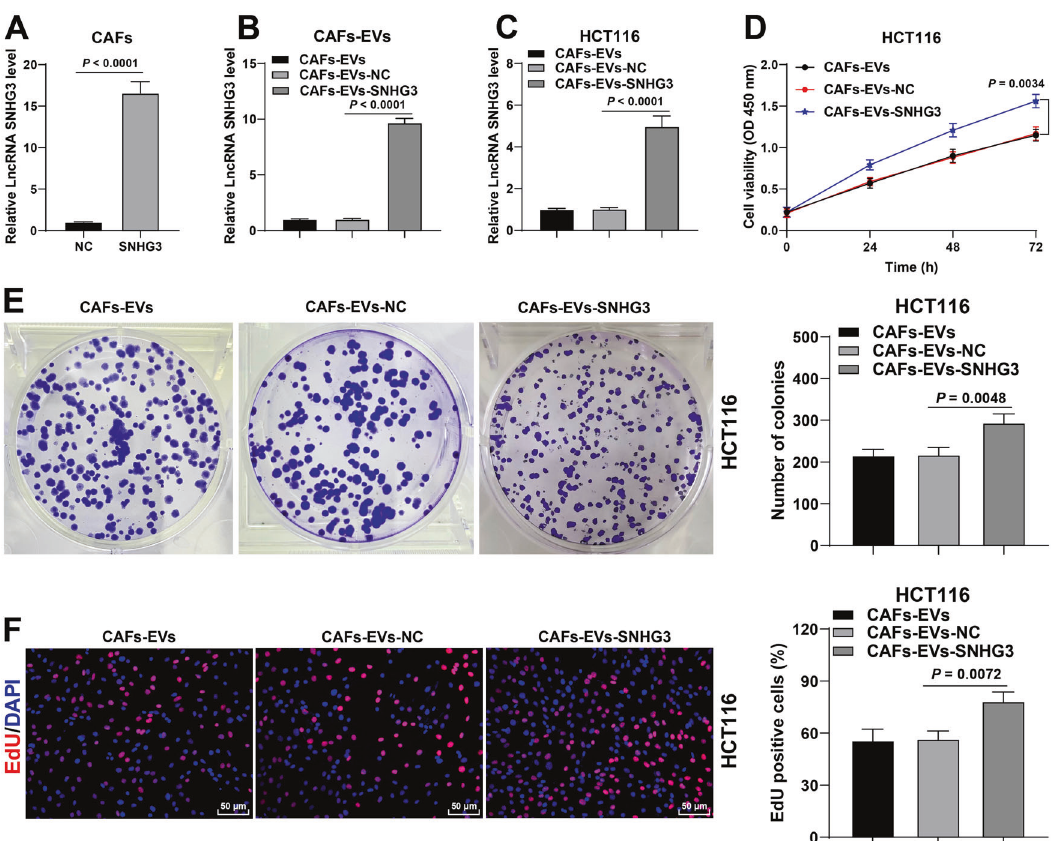
Fig. 3 CAFs-EVs carrying SNHG3 enhanced the proliferation of CRC cells. CAFs were infected with lentivirus overexpression vector of SNHG3. A SNHG3 expression in CAFs was determined using RT-qPCR. EVs were isolated from CAFs overexpressing SNHG3 (CAFs-EVs-SNHG3) to treat HCT116 cells. B SNHG3 expression in CAFs-EVs was determined using RT-qPCR. C SNHG3 expression in HCT116 cells was determined using RT-qPCR. D – F The cell proliferation ability was measured using CCK-8 assay ( D ), colony formation assay ( E ), and EdU staining ( F ). The cell experiment was repeated three times independently. Data are presented as mean ± standard deviation. Data in A were analyzed using t -test. Data in B , C / E , F were analyzed using one-way ANOVA, and data in panel D were analyzed using two-way ANOVA, followed by Tukey ’ s multiple comparisons